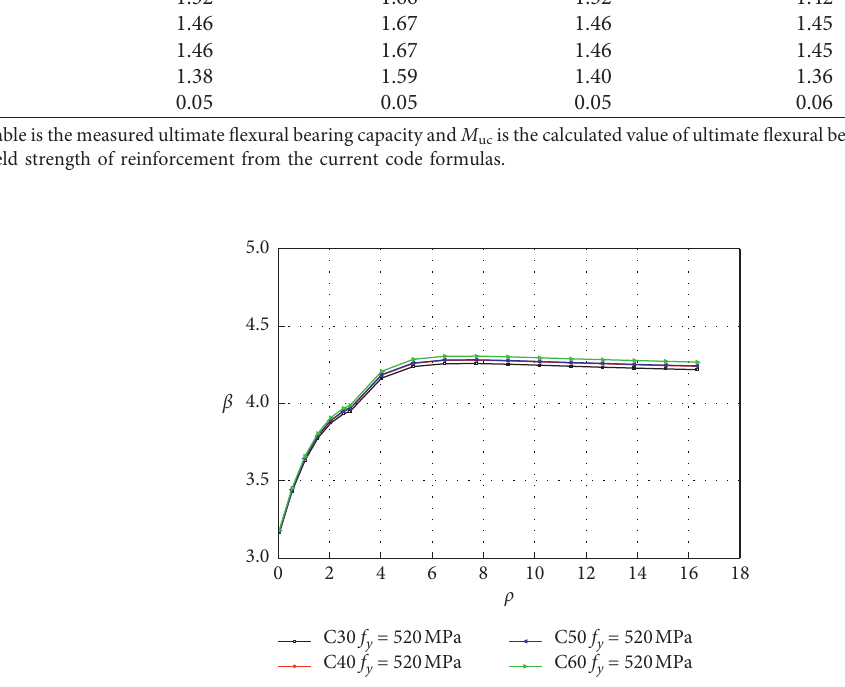
Figure 11: ρ - β Curve of different concrete strength grades with the reinforcement rate of 0.005.